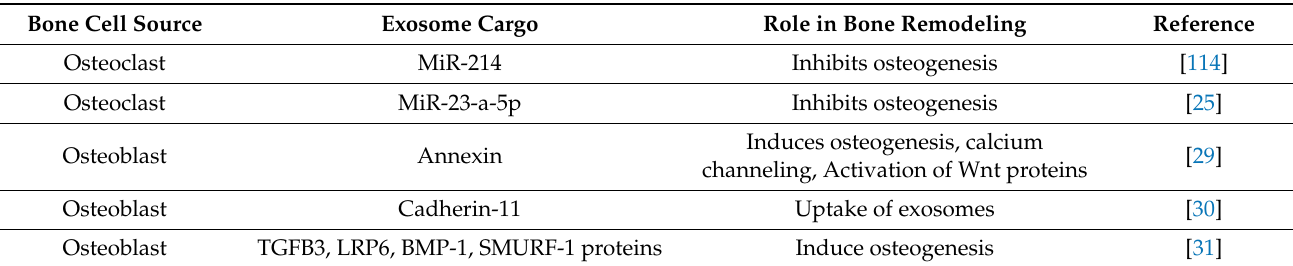
Table 1. Exosome cargo derived from bone cells and their role in bone remodeling. Bone Cell